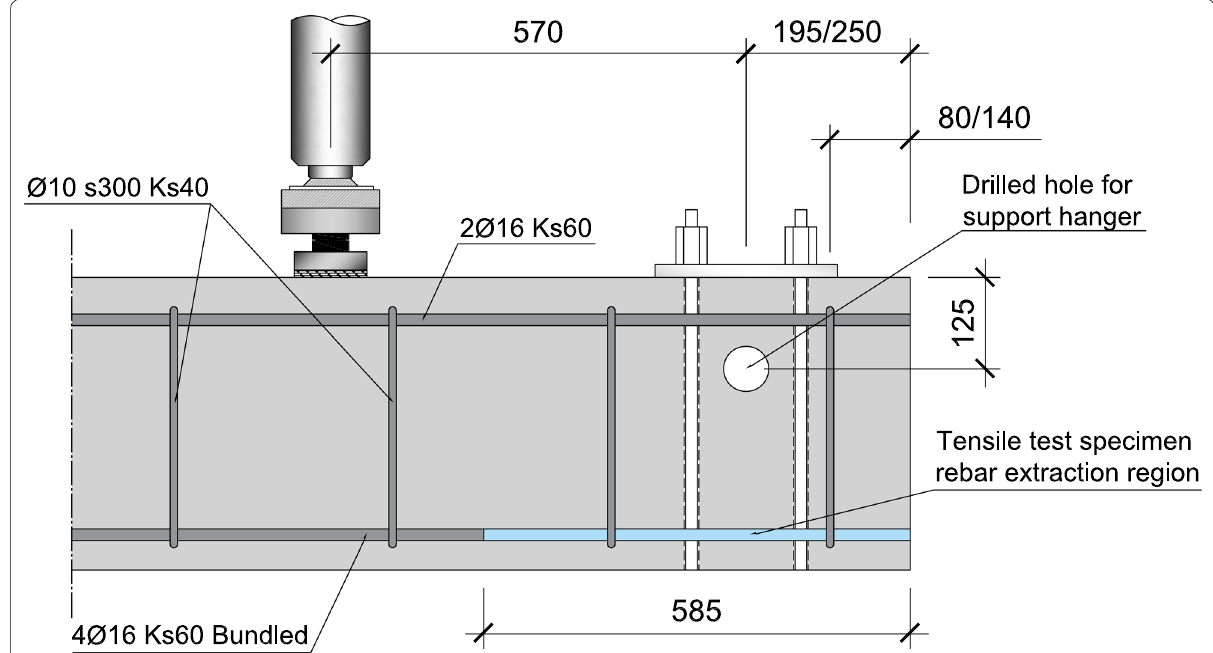
Fig. 1 Test-setup for suspended four-point bending test. Values expressed in